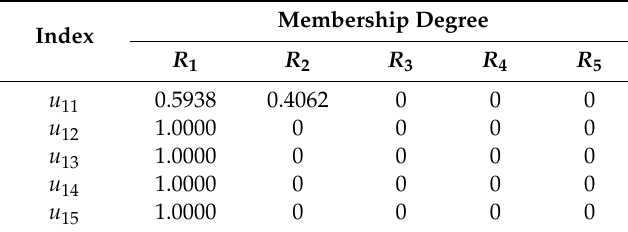
Table 9. Membership degrees of server influencing factors (R u 1 ).